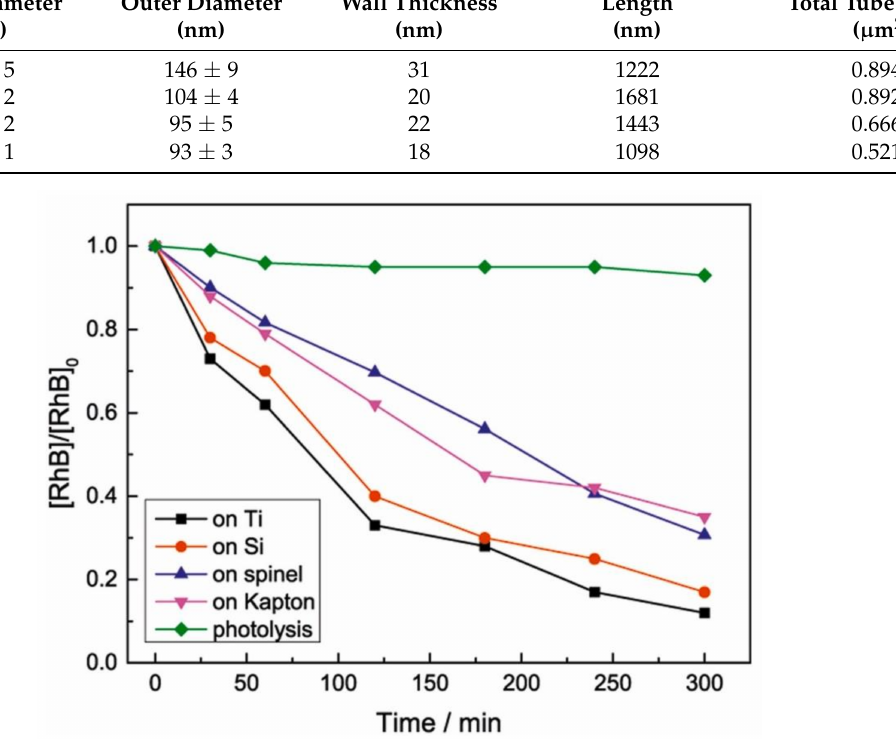
Figure 11. Photocatalytic degradation of RhB dye with UVA irradiation by TNTs grown on different substrates, i.e., ceramic spinel, Si wafer, polymeric Kapton film, and Ti foil. Reprinted with the permission from reference